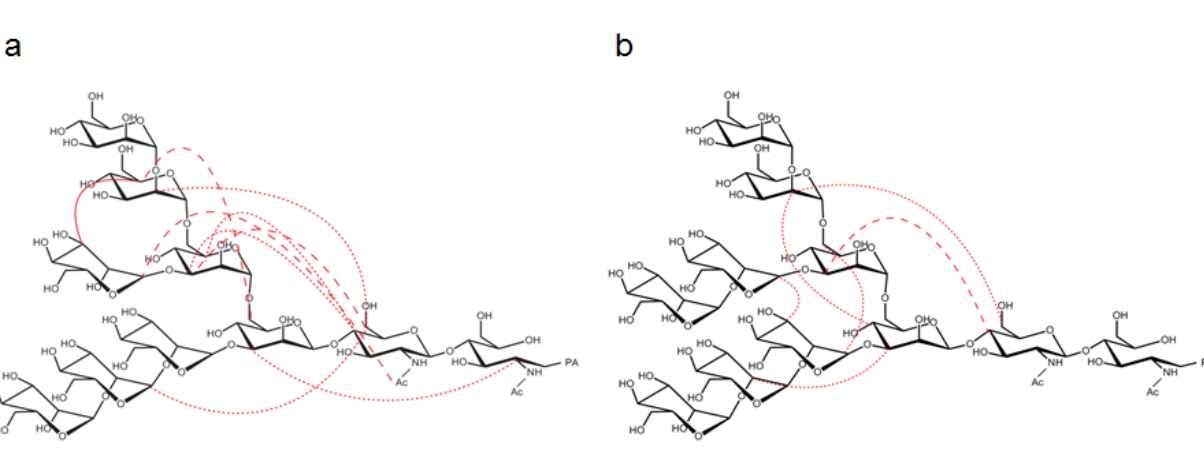
Figure 5. Summary of the long-range Nuclear Overhauser effect (NOE) connectivities identified in the (a) M8B and (b) M9 oligosaccharides. Interresidue NOEs are shown except for those observed between neighboring residues and those unassigned due to peak overlap. They are classified based on normalized intensity as follows: > 0.2 (solid). 0.2–0.1 (dashed), 0.1–0.03